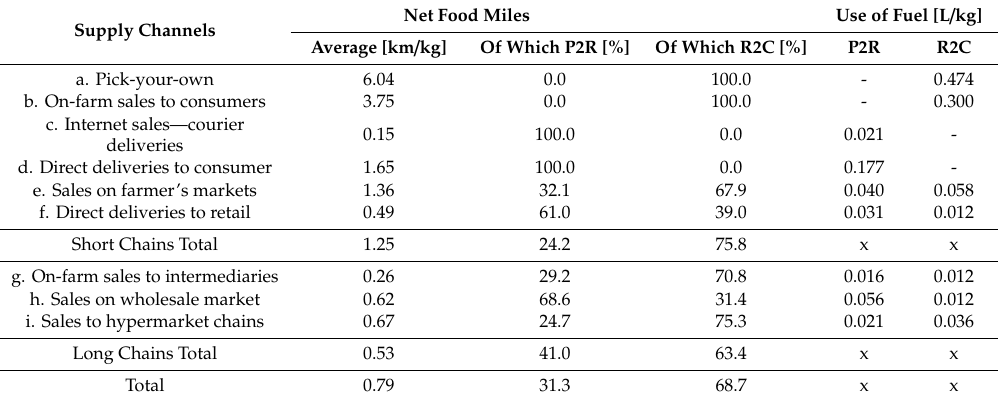
Table 10. Food Miles and transportation-related data for food supply chains in the